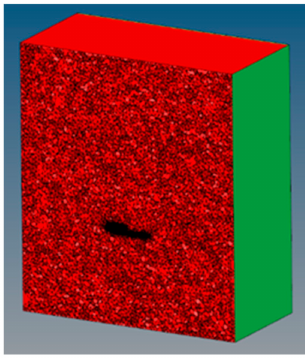
Figure 7. Average section of the components and air generated with tetrahedral Model. Source: our own elaboration from the software HyperMesh.